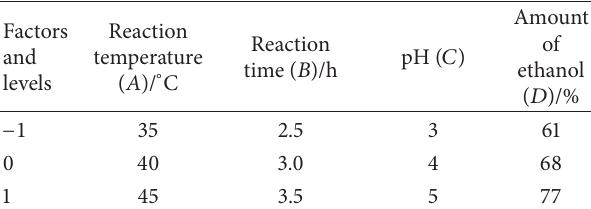
Table 1: Factors and levels of response surface test for